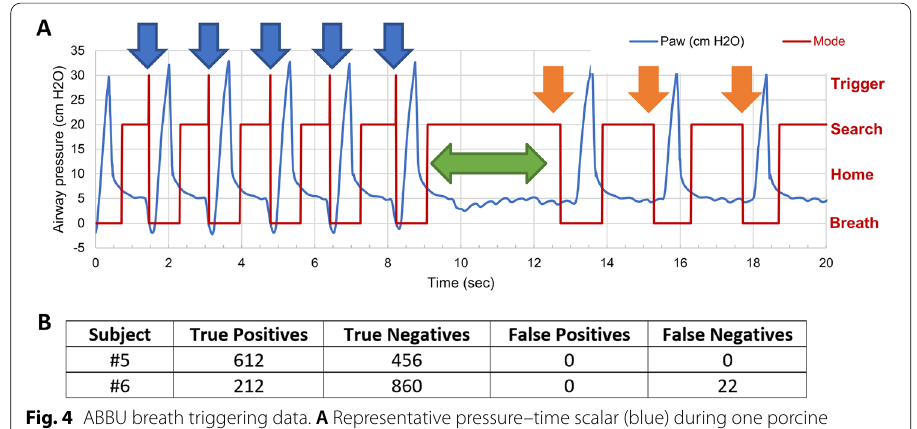
Fig. 4 ABBU breath triggering data. A Representative pressure–time scalar (blue) during one porcine experiment. The first five breaths are trigger assisted (blue arrows), followed by a two respiratory cycle pause (green arrow), followed by three control breaths (orange arrows). Mode Breath means a mechanical breath = is being is delivered, Mode Home means the motor is idle and Paw is below PEEP, Mode Search is when = = it calculates PEEP and is searching for a patient effort, and Mode Trigger means a breath assist is triggered. = B Summary of trigger assist algorithm ( n 2). Note that Subject #6 had 22 false negatives (ineffective = triggering) attributed to inability of the algorithm to calculate the sensing threshold below PEEP